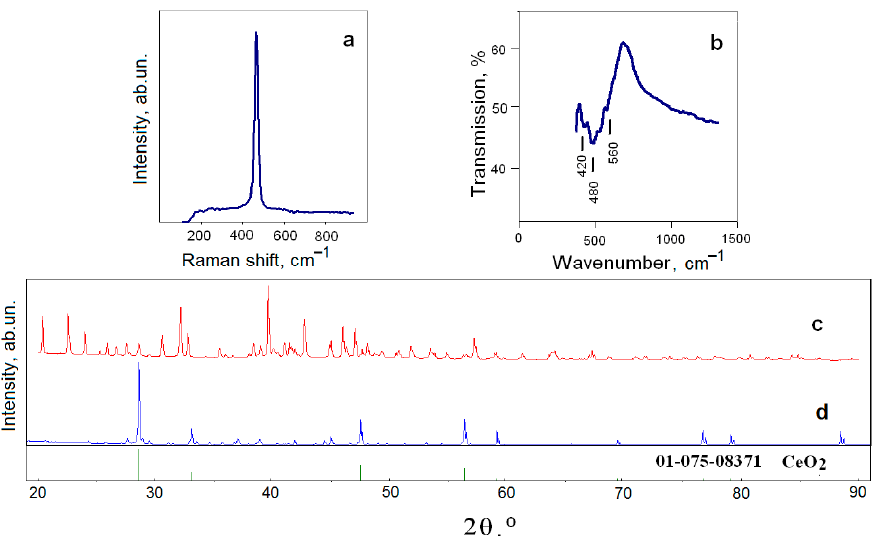
Figure 5. Analysis (at 20 °C) of the solidified 0.85FLiNaK–0.15 CeF 3 melt after 1 h exposure in air atmosphere at 700 °C: ( a ) Raman spectrum; ( b ) IR spectrum; ( c ) XRD pattern of the 0.85FLiNaK–0.15CeF 3 composition before air treatment; (d) XRD analysis of the solidified 0.85FLiNaK–0.15CeF 3 melt after 2 h exposure in the air atmosphere at 700 °C.